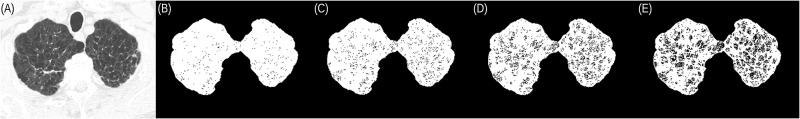
Representative CT and binarized images at multiple threshold levels.(A) CT image; (B)–(E) binarized images at threshold levels of −975, −950, −925, and −900 HU. Note: Fig 3(A) is identical to Fig 1(C). The CT images were displayed with a lung window setting of 1600 HU window width and −550 HU window level.